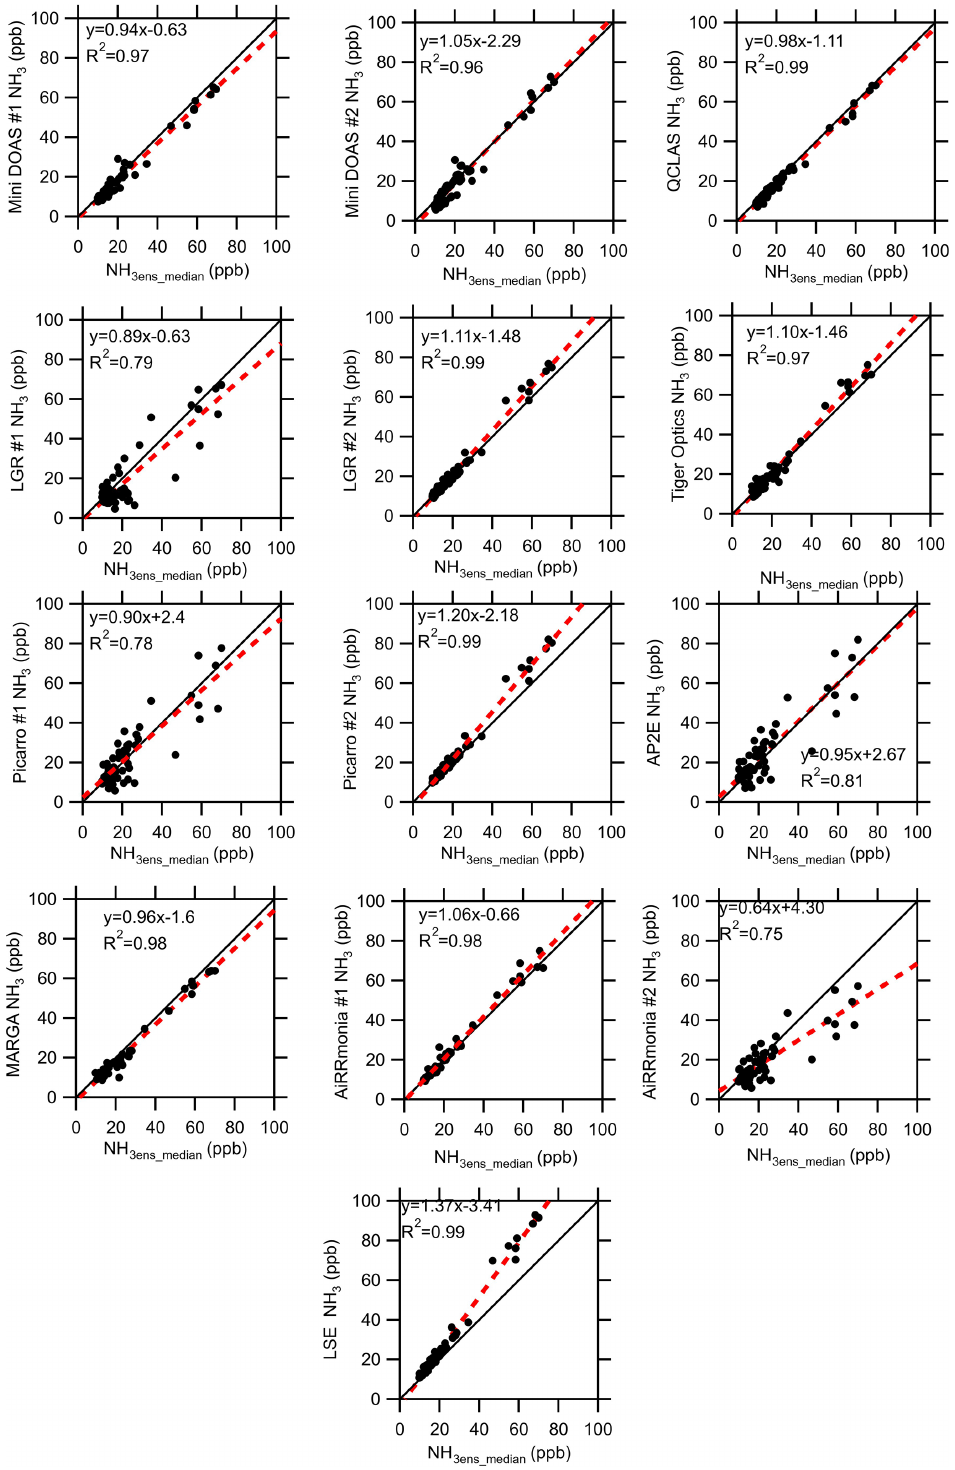
Figure 9. Intercomparison of instruments’ (hourly) averages from 22 to 29 August 2016 to the ensemble median (excluding LGR #1 and Tiger Optics) when the median is equal to or greater than 10ppb NH 3 . Data were filtered for low wind speed and stable and unstable conditions that could have led to inhomogeneity at the site. The solid black line is the 1:1 line, and the red dashed line is the fit.